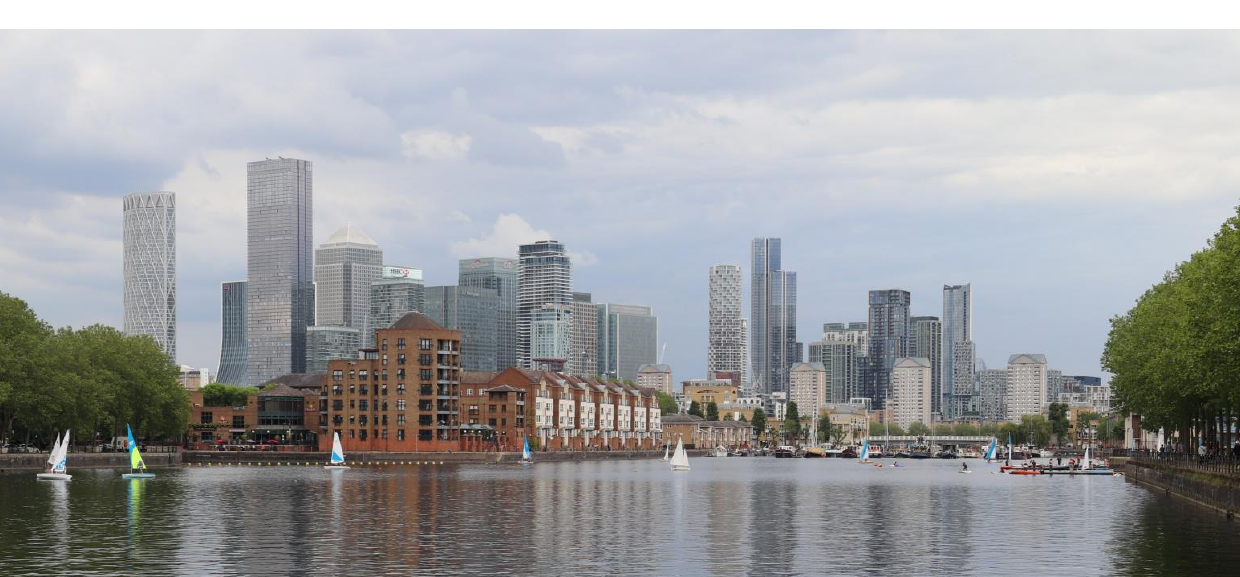
Figure 17. Panorama of the Isle of Dogs tall buildings’ clusters from the Greenland Dock in the sun set (2021). Introduction of residential towers to the Isle of Dogs is currently the leading driver for application of colour in the architecture of tall buildings. Colour is applied to the large scale elements of the architectural composition in order to introduce finer grain and do- mestic feel to tall buildings. 4. Discussion The authors discussed theories of colour in architecture reflected in the research sam- ples, explored the physiology and psychology of colour as an element of living and work-